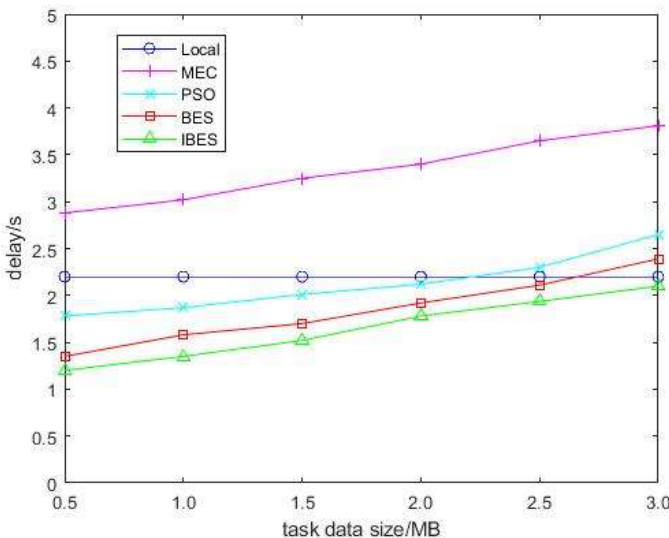
Figure 4. Comparison of time delays under different task data size.